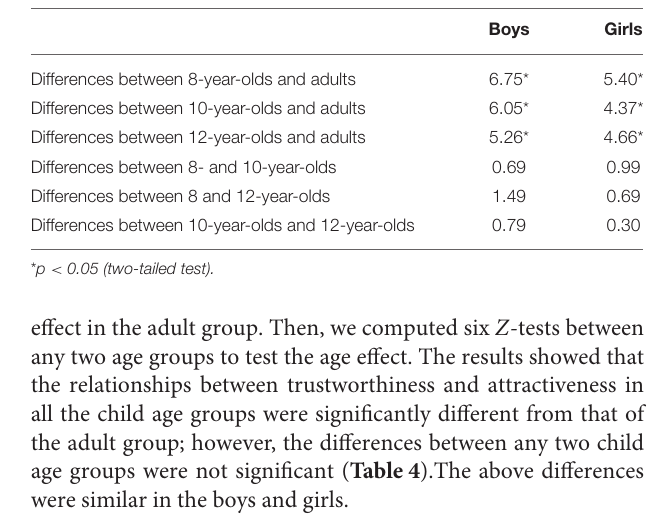
TABLE 4 | The results of Z -tests between any two age groups separately for boys and girls on the correlation of trustworthiness and attractiveness